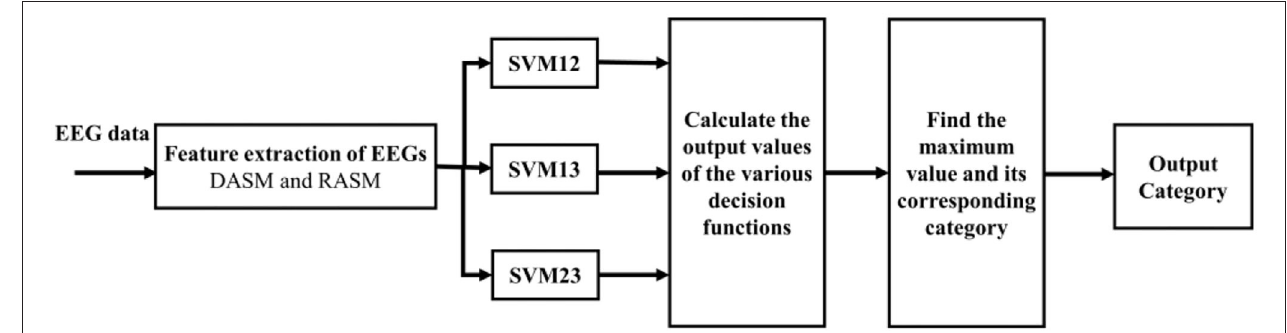
FIGURE 5 | Classification flowchart of